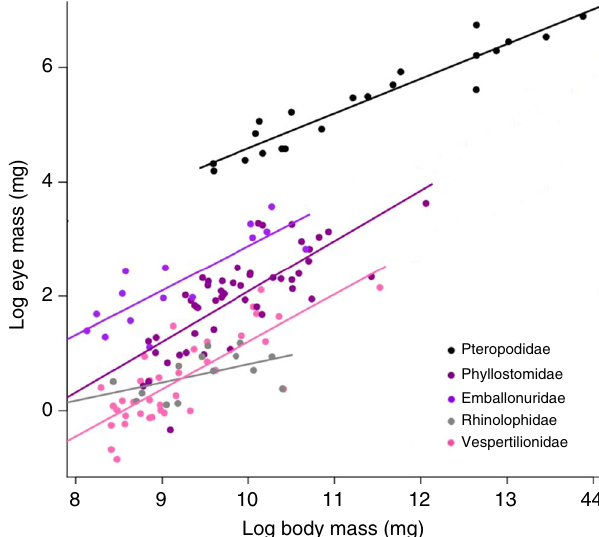
Fig. 5 Phylogenetically informed linear regressions of brain and eye mass on body mass by family. Phylogenetic generalized least square models showing the regressions of log-transformed eye mass ( N = 183) on body mass accounting for phylogenetic non-independence among data points. The 5 most speciose families of bats are shown separately on the plots. The pteropodids have the largest absolute eye size while the predatory emballonurids have the largest eyes among the laryngeal echolocating bats. The smallest eyes are found in the more advanced echolocating rhinolophids and vespertilionids, suggesting that there may be an echolocation-vision trade-off even among predatory